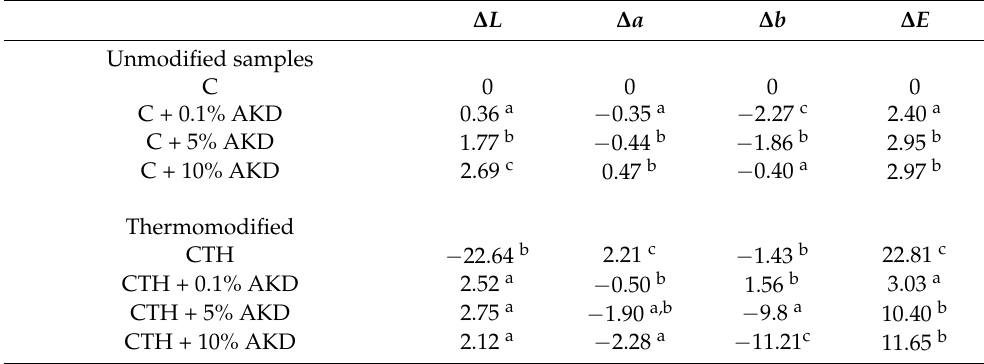
Table 2. Colour change (mean value) for both unmodified and thermally modified cedar wood samples after the AKD application. Means with the same letter are not significantly different from each other (p > 0.05 ANOVA followed by Duncan test) .